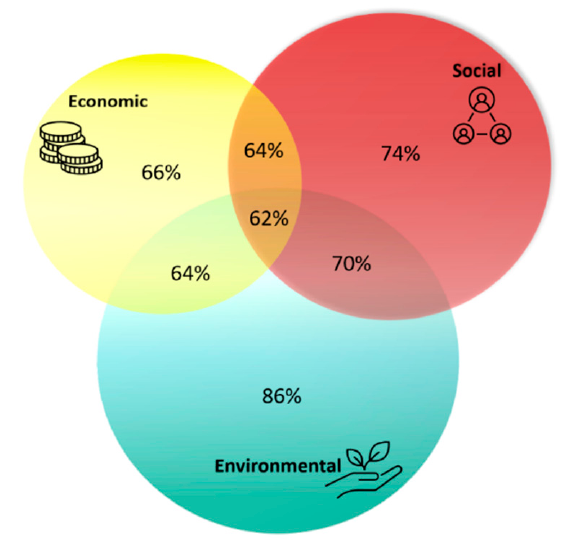
Figure 3. Sustainability dimensions covered by the tools.